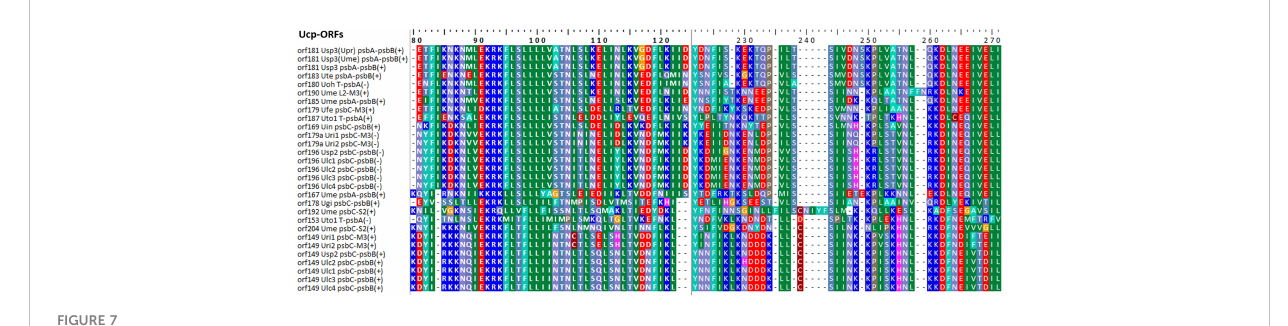
FIGURE 7 The conserved domain shared by the 29 Ucp-ORFs detected in Ulva